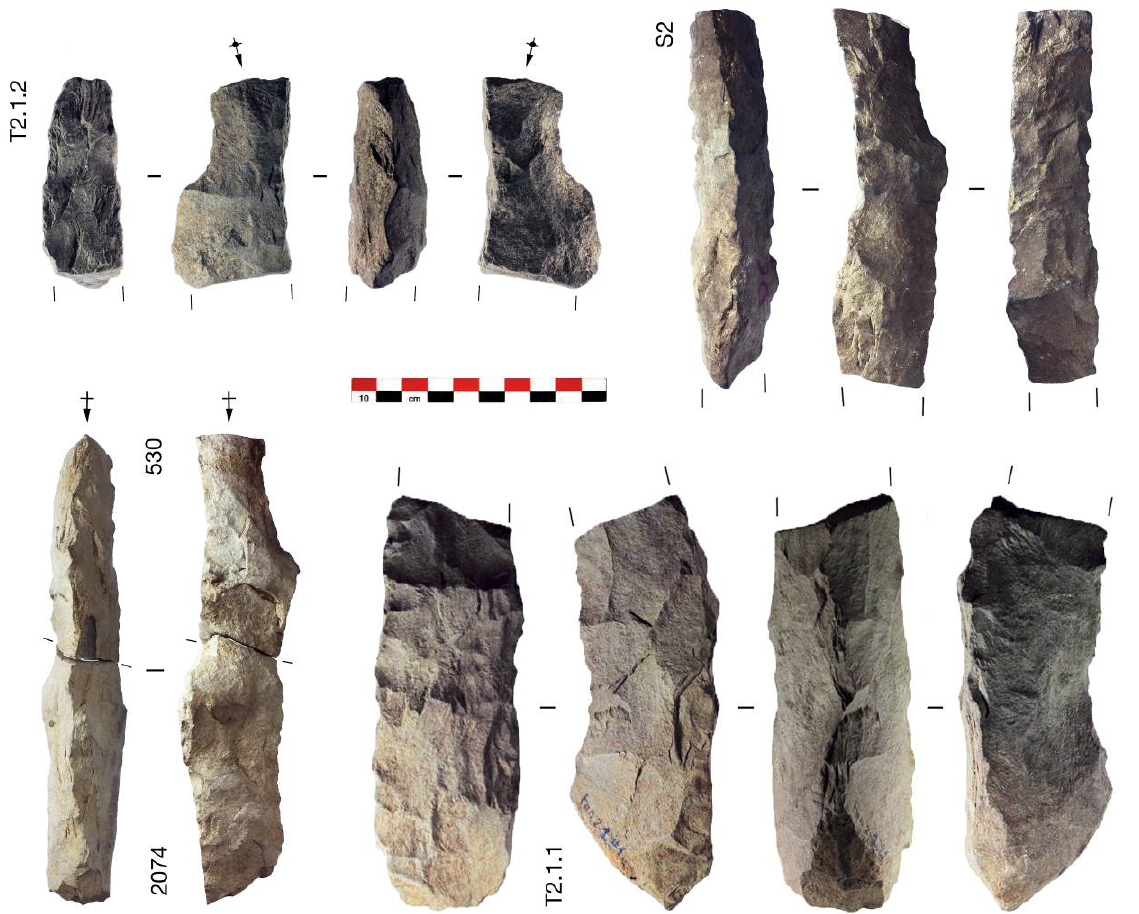
Figure 6. Préformes de Tanataetea: type 4A de Duff. Echelle de 10 cm (segments de 1cm) Figure 6. Tanataetea preforms: Duff type 4A. The scale bar in the image is 10 cm wide (separated into 1 cm